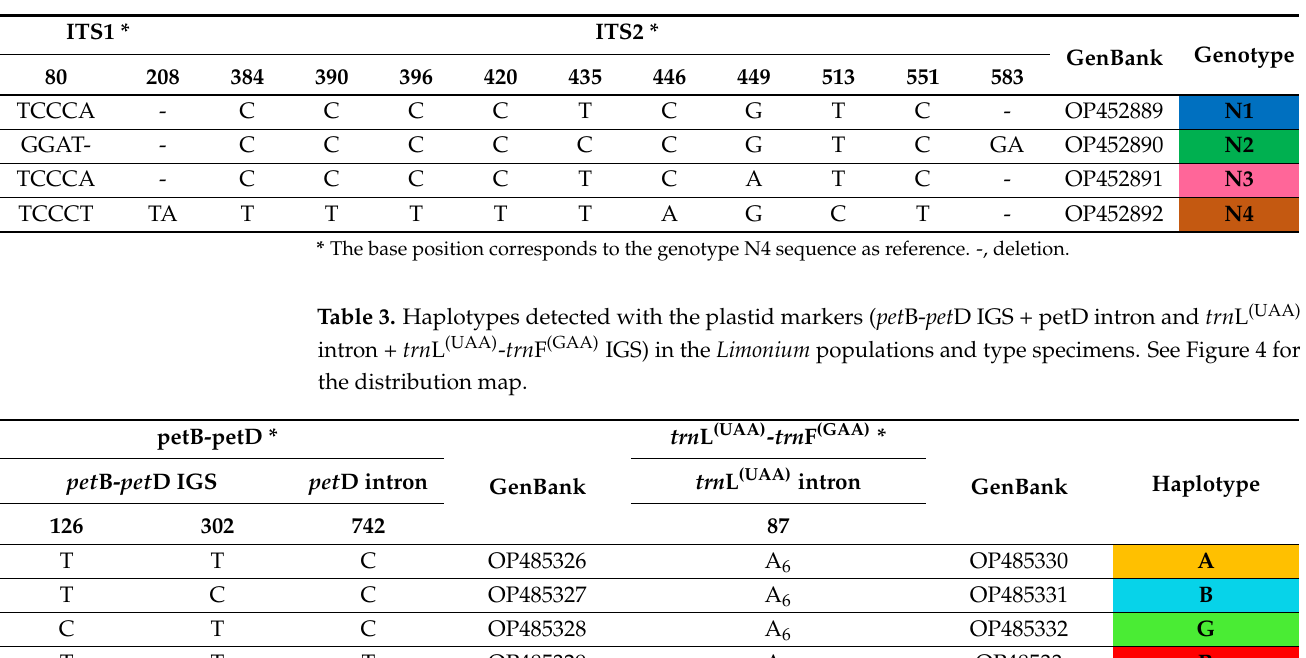
Table 2. Single genotypes detected with the nuclear markers (ITS1, 5.8S, ITS2) in the Limonium populations and type specimens. See Figure 3 for their distribution map.